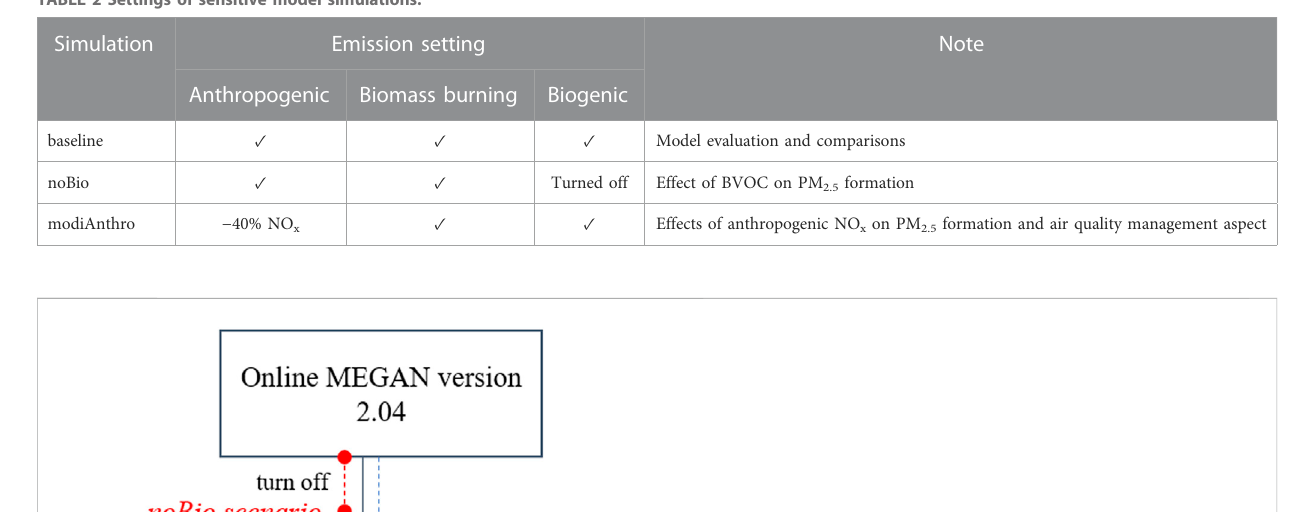
TABLE 2 Settings of sensitive model simulations.